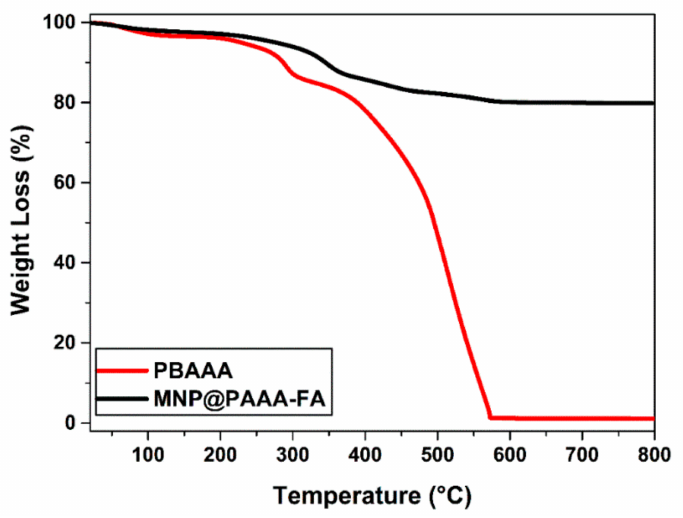
Figure 3. TGA curve of the starting polymer PBAAA and magnetic nanostructure MNP@PAAA-FA each performed in air at a heating rate of 10 ◦ C min − 1 between 30 ◦ C and 800 ◦